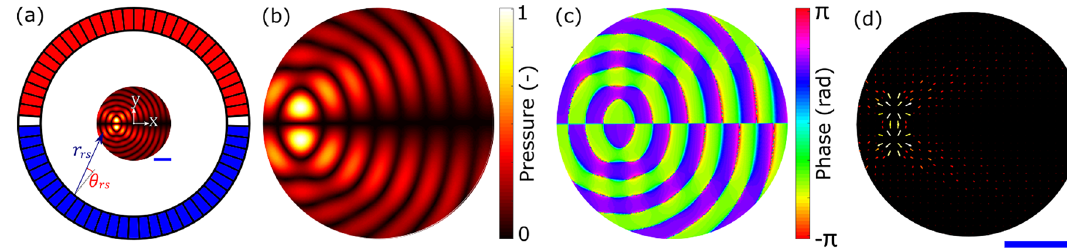
Figure 2. ( a ) Schematic of the circular phased array used in both the experiments and simulations. There are 64 phase and amplitude controlled elements around a circular chamber of 10.98 mm in diameter. The element colours indicate the phase offset for a twin trap, red and blue are π apart and the white elements are turned off. There will also be focusing phases to account for the location of the trap relative to the centre defined by Eq. (6). ( b ) An enlarged view of the pressure field amplitude in the central 4 mm diameter region showing a twin trap offset from the centre in the x-axis. ( c ) The pressure field phase of the twin trap (on the same scale as ( b )). ( d ) The resultant force field from the pressure field (on the same scale as ( b )). The blue scale bar is 1 mm.